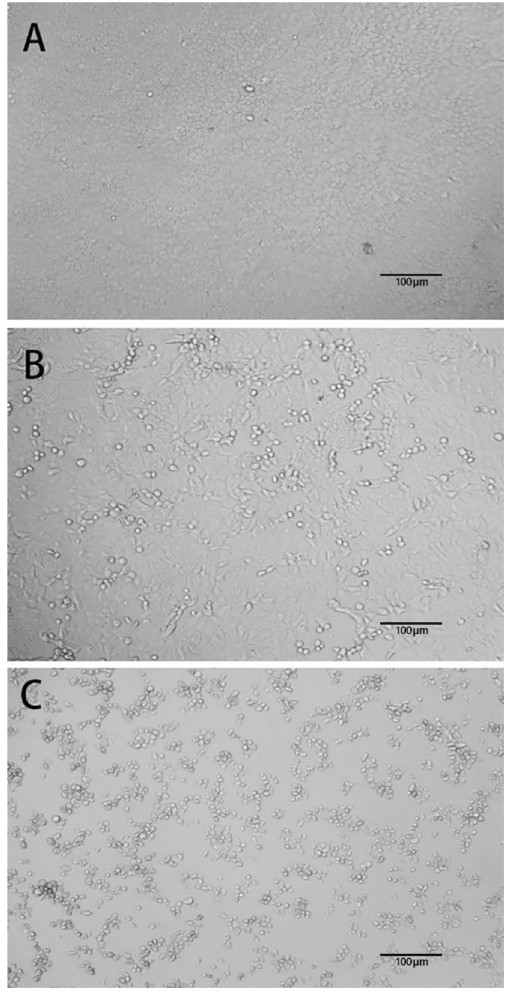
Figure 1. Morphology of Vero-E6 cells under a tenfold magnification in different infection states. ( A ) Intact cells. Vero-E6 cells formed a complete monolayer before SARS-CoV-2 infection. ( B ) Partially infected cells. After SARS-CoV-2 and disinfectant (20% ethanol) addition, some cells died and dislodged from the bottom of the 96-well plate, indicating incomplete disinfectant action. ( C ) Fully infected cells. After infection with SARS- CoV-2 alone, all cells died and were completely detached from the bottom of the 96-well plate.